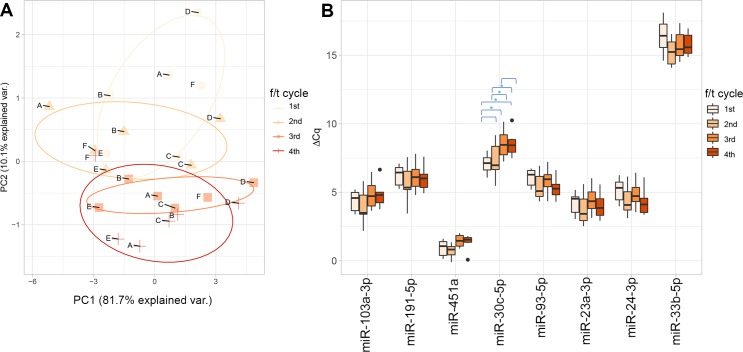
Effects of freeze-thaw cycles on detected levels of circulating miRNA in plasma samples.(A) Scatterplot of the first two principal component scores from the PCA analysis of storage time data (Nf/t = 6). Principal components one (shown on the x-axis) and two (y-axis) explain 81.70% and 10.10% of the data variance, respectively. Symbols and colors correspond to storage time to facilitate visual inspection, and a confidence ellipse for the population mean was drawn around the grouped observations to visualize the variance (data with higher variance creates larger confidence ellipses). (B) Boxplots of miRNA levels. The lower and upper hinges of the box present the first and third quartiles (25th and 75th percentiles), and the whiskers extend to 1.5 * IQR (interquartile range) in both directions; data beyond the whiskers are plotted individually. The x-axis lists the name of the miRNAs, while the y-axis shows the miRNA level, calculated as ΔCq normalized to the median level of the synthetic oligonucleotide UniSp6. Smaller ΔCq values denote greater miRNA levels and are characteristic of miRNAs commonly found in plasma, whereas larger ΔCq values are characteristic of miRNAs detected in low concentrations in the sample. Freeze-thaw (f/t) cycles are denoted by specific colors: one f/t cycle with orange, two f/t cycles with green, three f/t cycles with blue, and four f/t cycles with purple. Pair-wise comparisons are also shown, where significant differences as found by Tukey’s test are marked with a star.